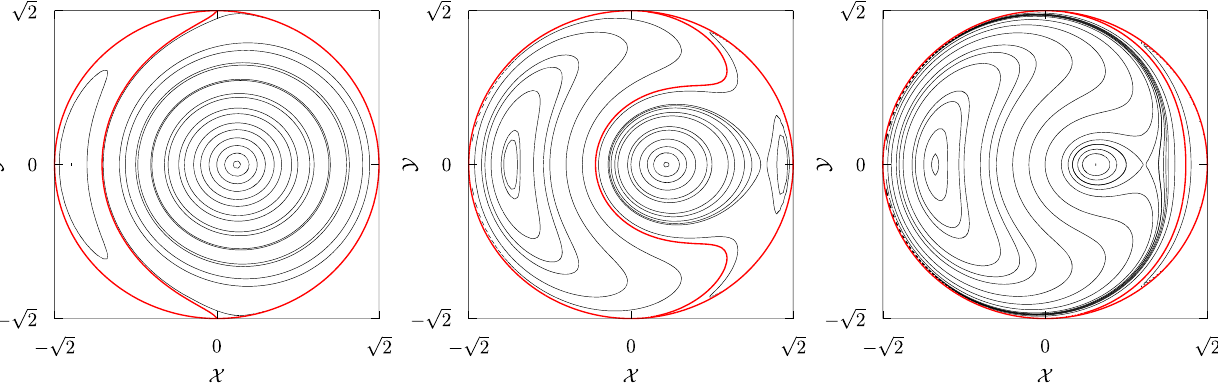
1 , α 0 , q ¼ 0 . 25 , J 1 at δ ¼ − 1 (left), δ ¼ − 0 . 58 (center), ffiffiffi aa ¼ ab ¼ b ¼ p 2 are shown in